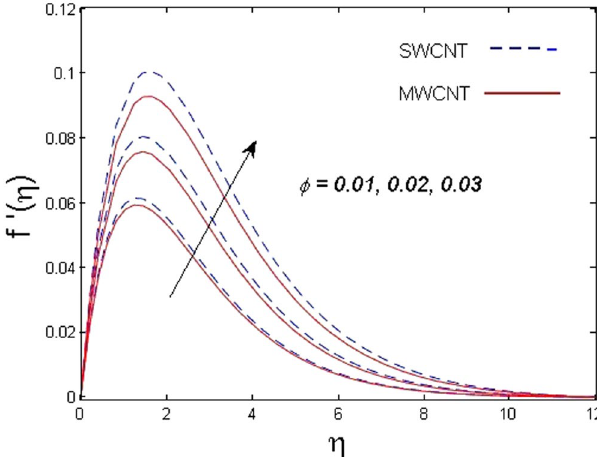
Figure 2. Outcome of φ on f ( ) η ′ .